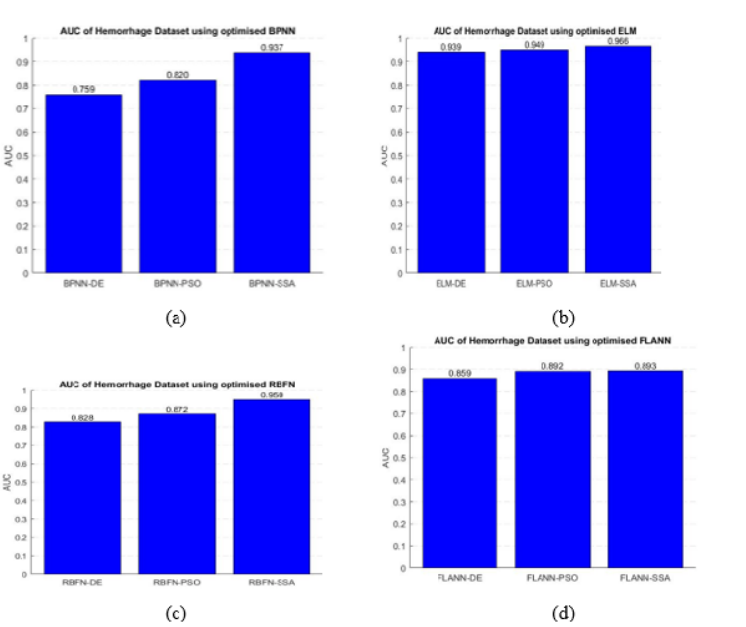
Figure 14. Comparison of AUC values for Hemorrhage dataset from models ( a ) BPNN, ( b ) ELM, ( c ) RBFN, or ( d ) FLANN. Table 5. ComparisonofAccuracyandAUCofhybridmodelsusingAlzheimer’sandHemorrhage datasets.